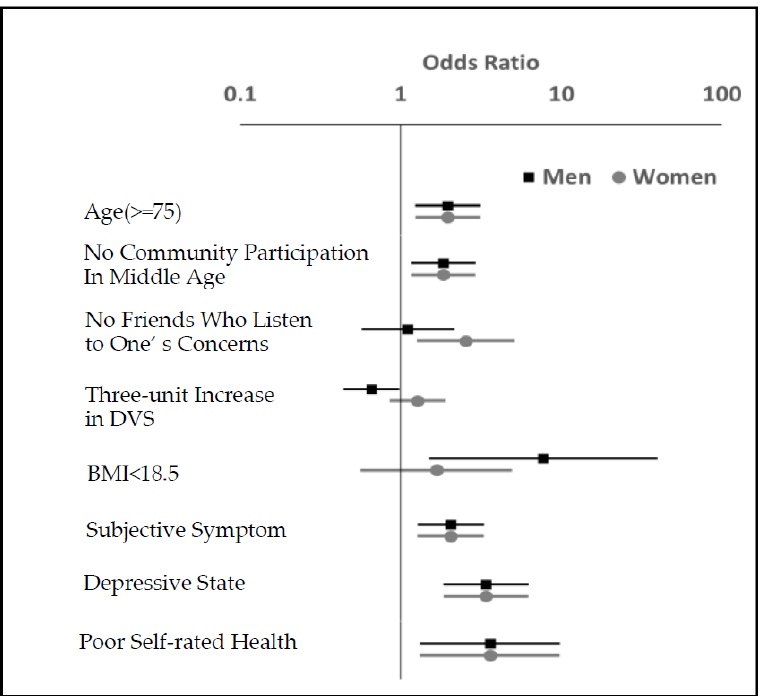
Figure 1. Gender differences associated with pre-frailty. The estimated odds ratios in Table 2 are visually displayed.